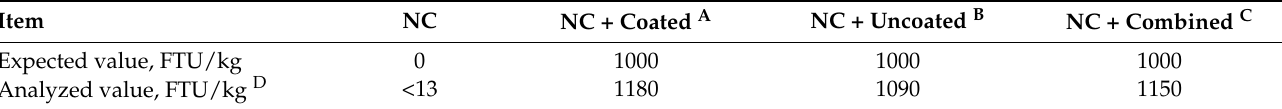
Table 2. Analysis of phytase activity in the negative control (NC) and phytase-supplemented